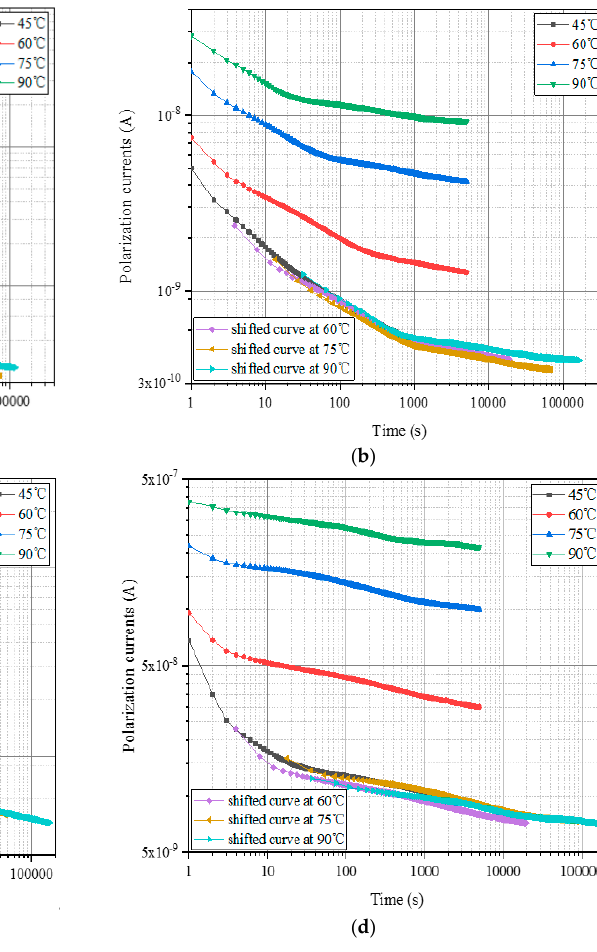
Figure 6. Temperature correction results of the verification samples. ( a ) DP = 795, mc % = 1.21%, ( b ) DP = 634, mc % = 1.74%, ( c ) DP = 525, mc % = 2.34%, ( d ) DP = 512, mc % = 3.52%.